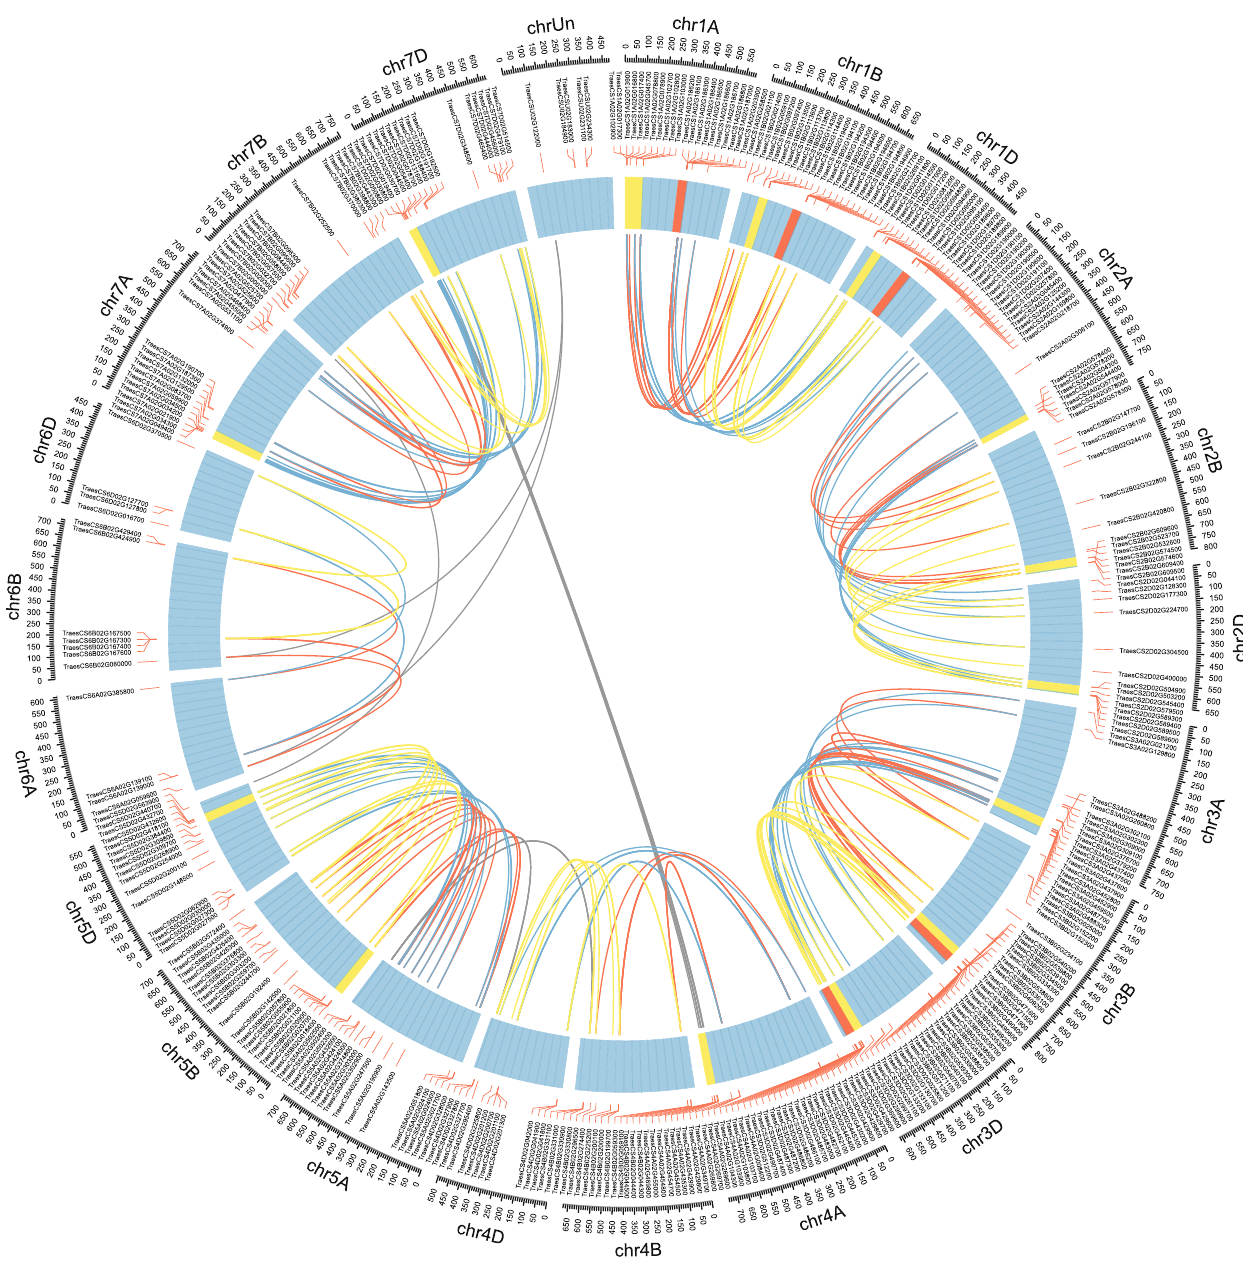
Figure 3: Genome-wide synteny analysis of glutathione S-transferase (GST) genes in common wheat. Syntenic GST gene pairs belonging to the same linkage group between AA and BB, AA and DD, and BB and DD are linked with red, blue, and yellow lines, respectively. Syntenic GST gene pairs between di ff erent linkage groups are linked with gray lines. The heat map track indicates the density distribution of GST